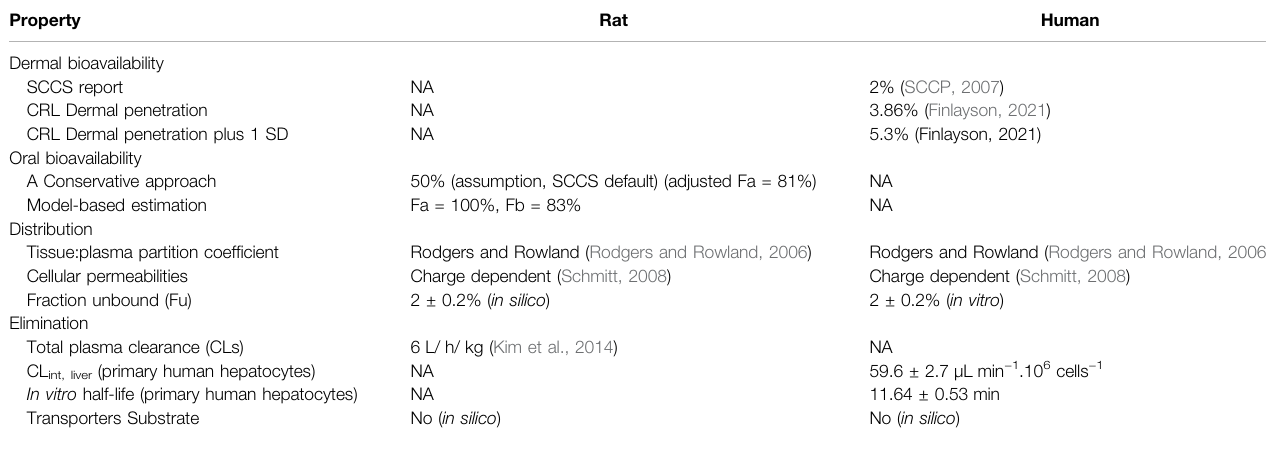
TABLE 2 | Homosalate parameters used for rat and human model building. Values were obtained from human based in vitro assays from the literature, collected from the SCCS report on homosalate 2007 (SCCP, 2007) or newly generated data (unpublished). NA (cid:1) not applicable. Property